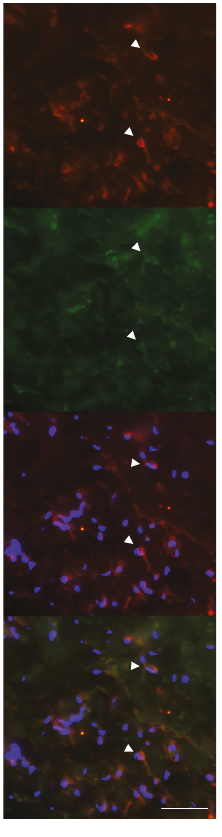
Figure 5: Double-labelling of PAI-1 (red) and CD45 (green) in an irradiated artery. Arrowheads indicate colocalization of PAI-1 and CD45, suggesting expression of PAI-1 in leukocytes. Nuclear stain (DAPI) is shown in blue (scale bar =50 μ